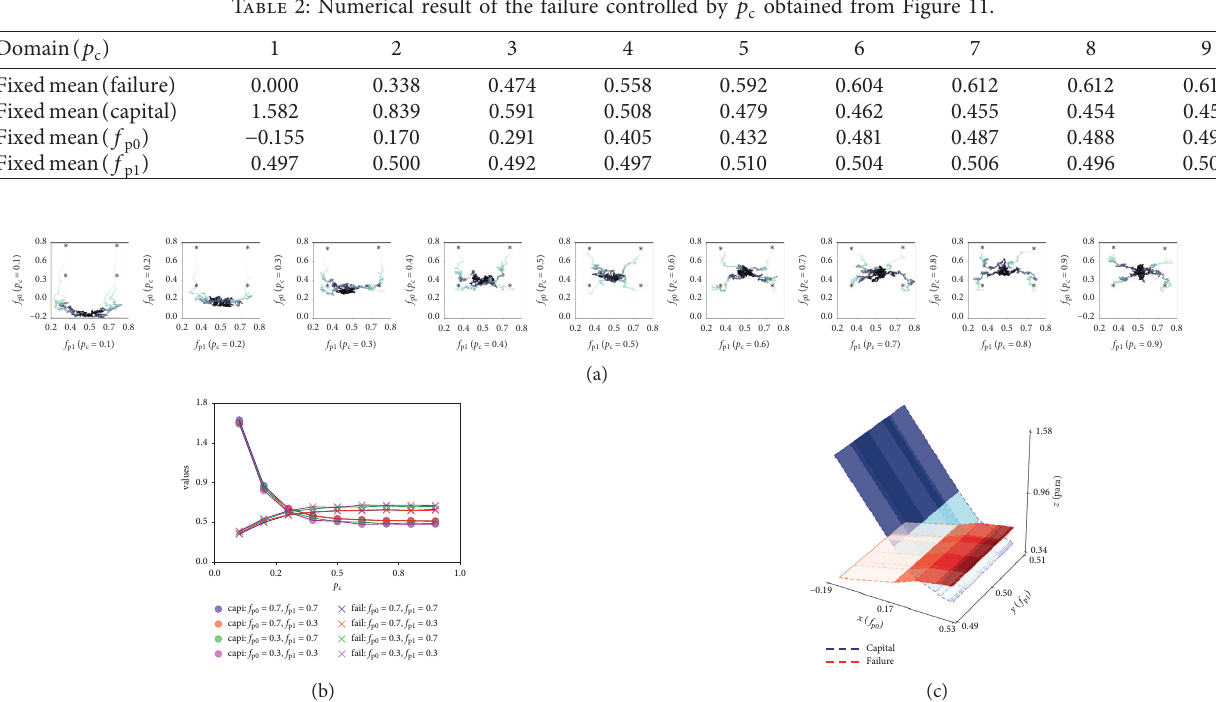
Figure 11: Stationary observation according to time step. The plots of the upper side show their averaged trajectories (asterisk � initial points of the strategies, strength of the color � time steps: t � 1 (weak) ∼ t � 4000 (strong), dots � averaged value of the trait according to time � 0.7, f � 0.7, upper left: f � 0.7, f � 0.3, bottom right: f � 0.3, f � 0.7, and bottom left: step from the initial points; upper right: f p0 p1 p0 p1 p0 p1 f � 0.3, f � 0.3). The plot of the bottom left side shows the averaged outcomes value (vertical axis) of the capital (marker � ○ ) and the p0 p1 (horizontal axis) with different initial points of the strategies (see legend). The plot of the bottom failure (marker � X ) according to the p c right side shows the average capital (blue) and failure (red) probability as functions of the strategies ( f , f ) with three-dimensional p0 p1 representation.